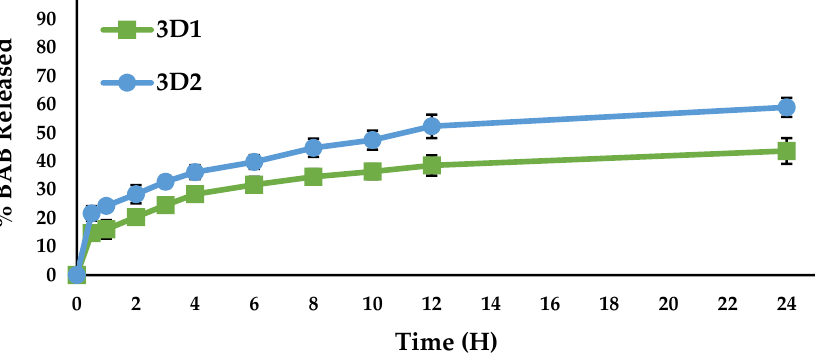
Figure 8. Percentage drug release—time plot for 3DP1 and 3DP2.